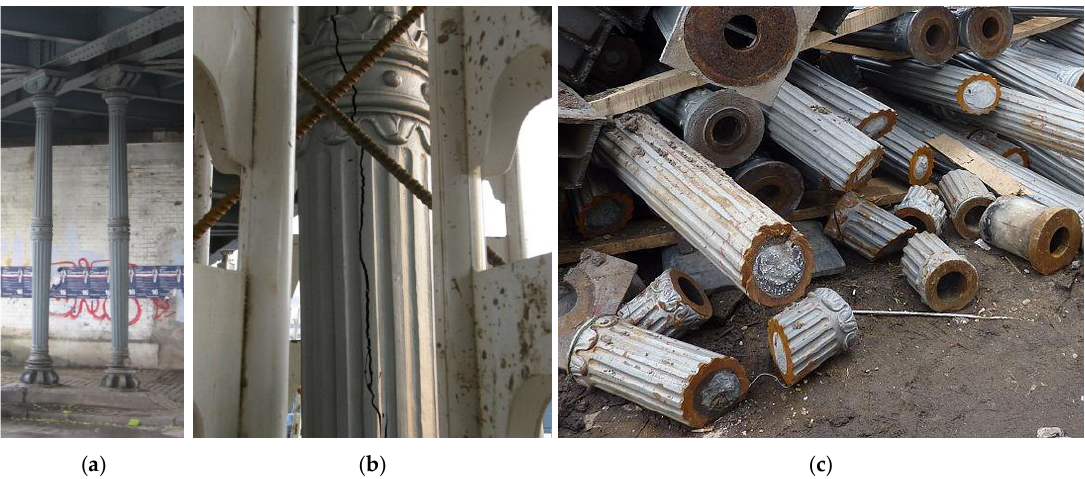
Figure 19. Hartung’s columns supporting the railway overpass at Stysia st. in Wrocław: ( a ) original elements, ( b ) view of the damaged column, ( c ) disassembled columns in the landfill.